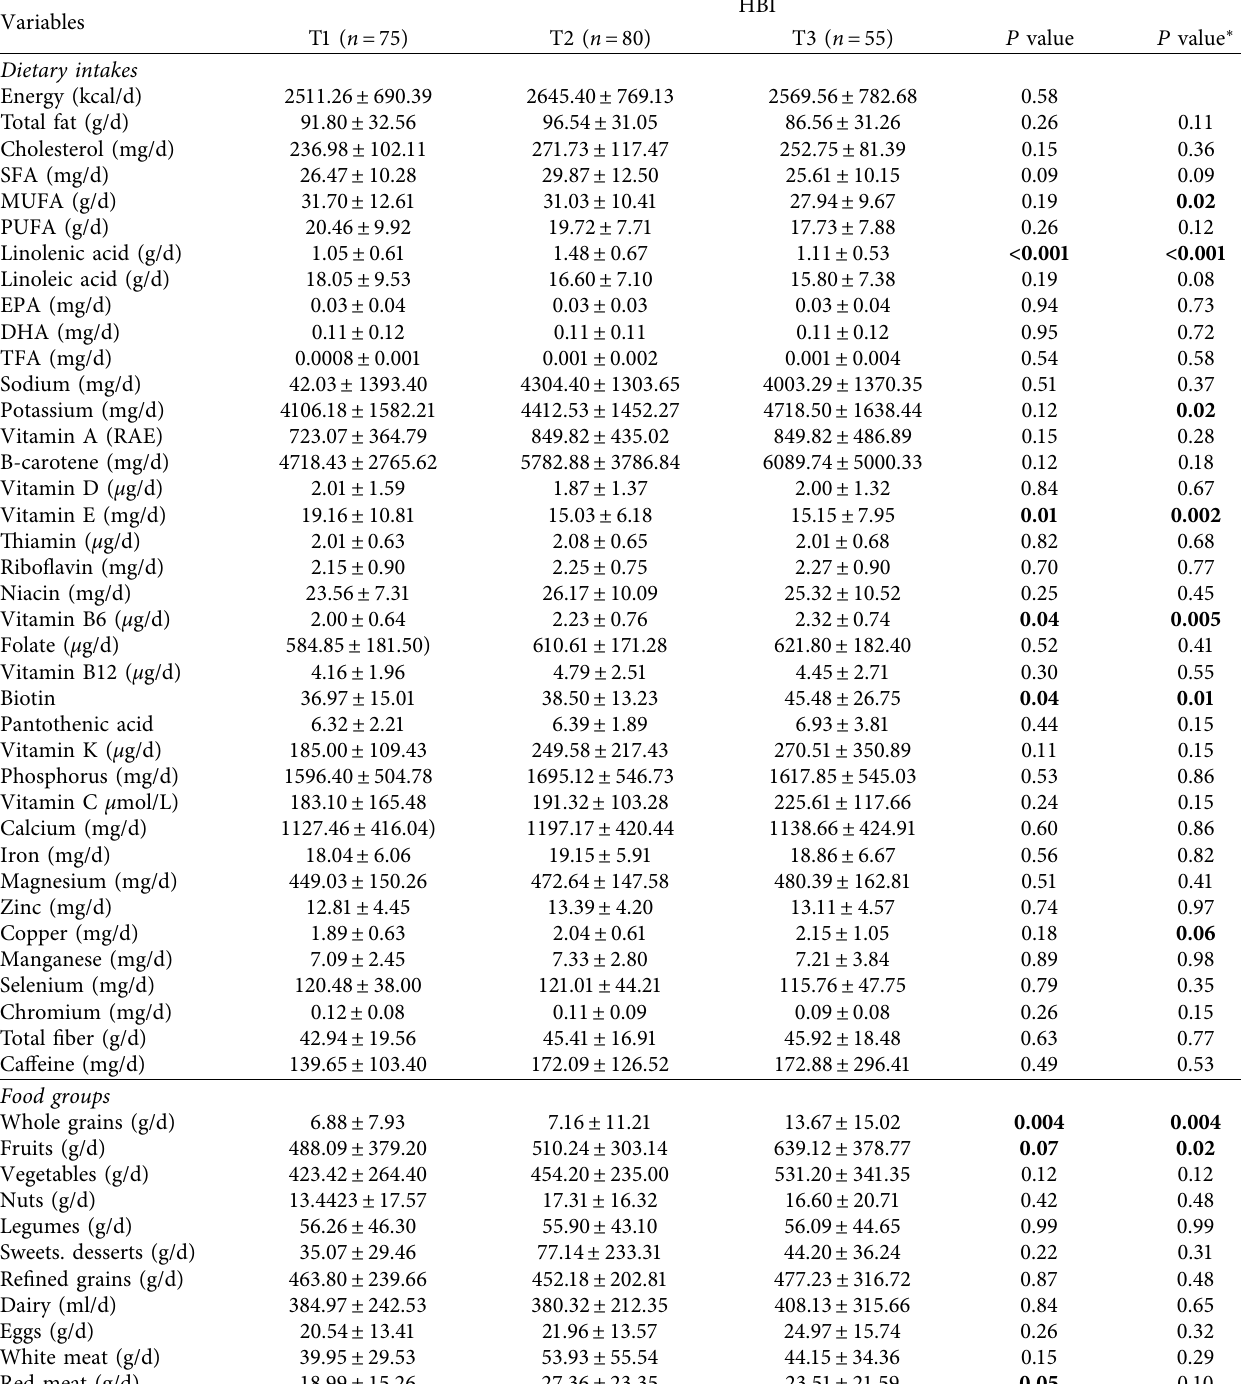
Table 3: Nutrient intake according to tertiles of healthy beverage